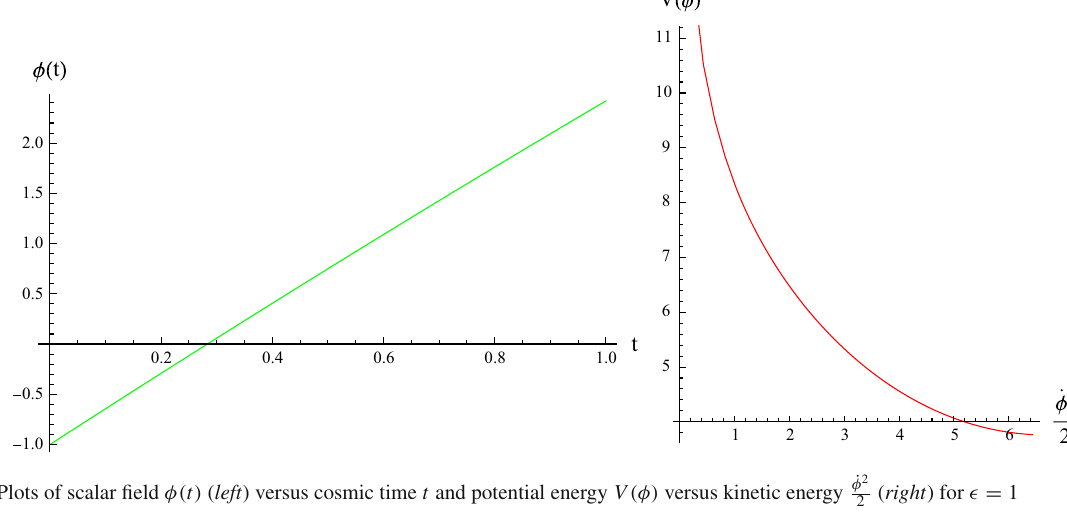
Fig. 4 Plots of scalar field φ( t ) ( left ) versus cosmic time t and potential energy V (φ) versus kinetic energy